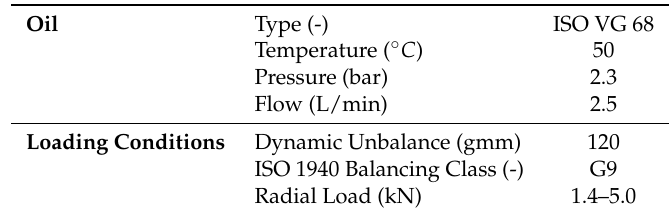
Table 4. Test conditions.